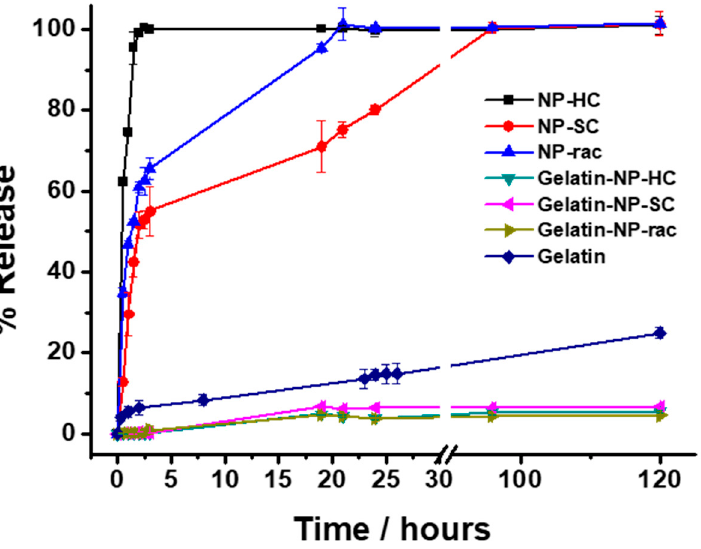
Figure 9. Release profiles of DOX from nanoparticles in suspension (NP-HC, NP-SC and NP-rac), gelatin (Gelatin) and nanoparticles embedded in gelatin (Gelatin-NP-HC, Gelatin-NP-SC and Gelatin-NP-Rac) in PBS pH 7.4 at 37 °C. The drug releases were tested in three replicates. Error bars are 2 σ .